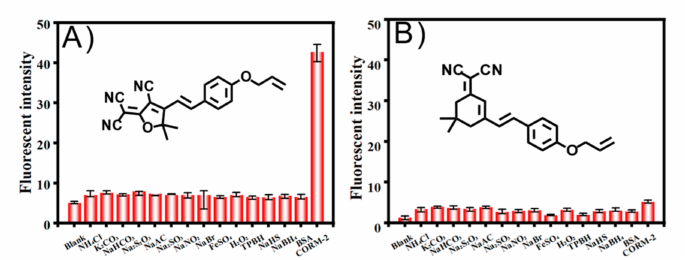
Figure 6. Fluorescent intensity responses of the probe system ( A ) TCF-ether and ( B ) DCI-ether in the presence of PdCl 2 (50 µ M) for various analytes (100 µ M, except 20 µ M of CORM-2). TCF-ether: λ ex = 580 nm, DCI-ether: λ ex = 560